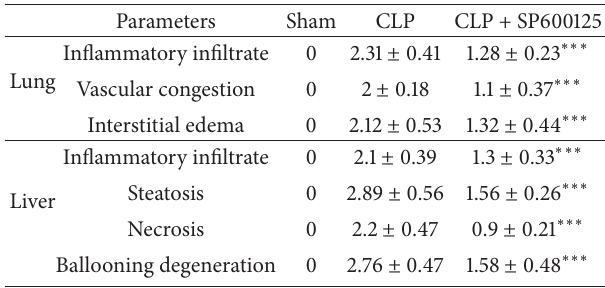
Table 1: SP600125 effects on lung histologic damage in CLP mice. ∗ ∗ ∗ is for 𝑃 < 0.0001